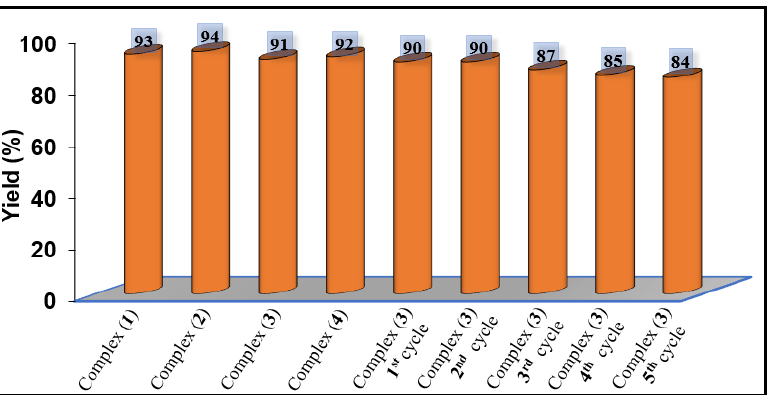
Figure 18. Bar diagrams presenting yield by different catalysts and results of five recycles of